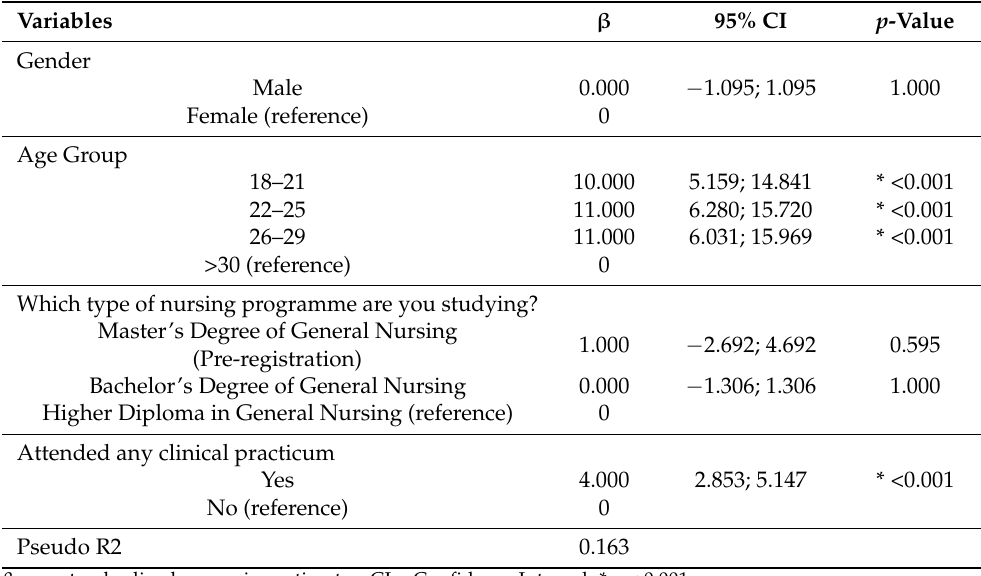
Table 3. Results of quantile regression analysis to predict the total scores of the FCV-19S. Variables